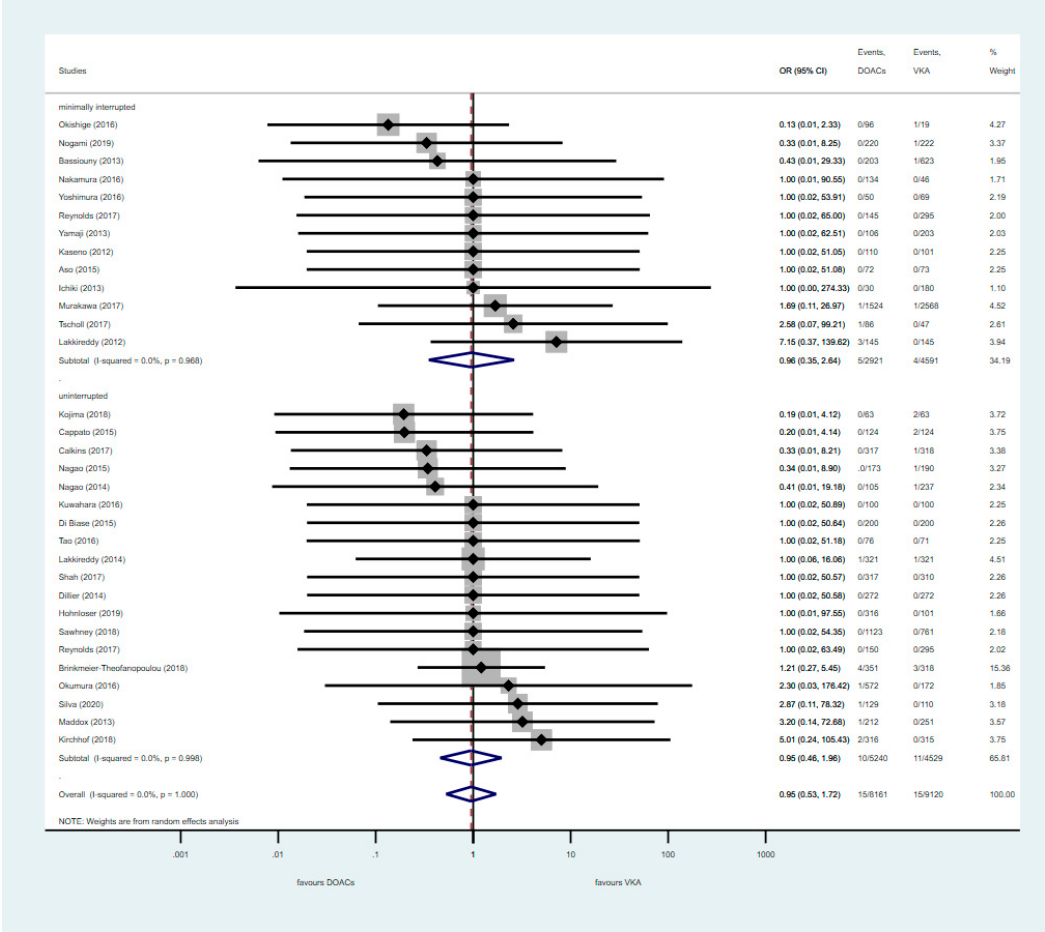
Figure 2. Primary e ffi cacy outcome of stroke or transient ischemic attack (TIA) with uninterrupted or minimally interrupted DOAC strategies vs. VKA. CI: Confidence Interval; OR: Odds Ratio; DOAC: Direct Oral Anticoagulants; VKA: vitamin K antagonist. The diamond defines the overall result of each given group, the dotted red line is there to graphically show the overall results of the